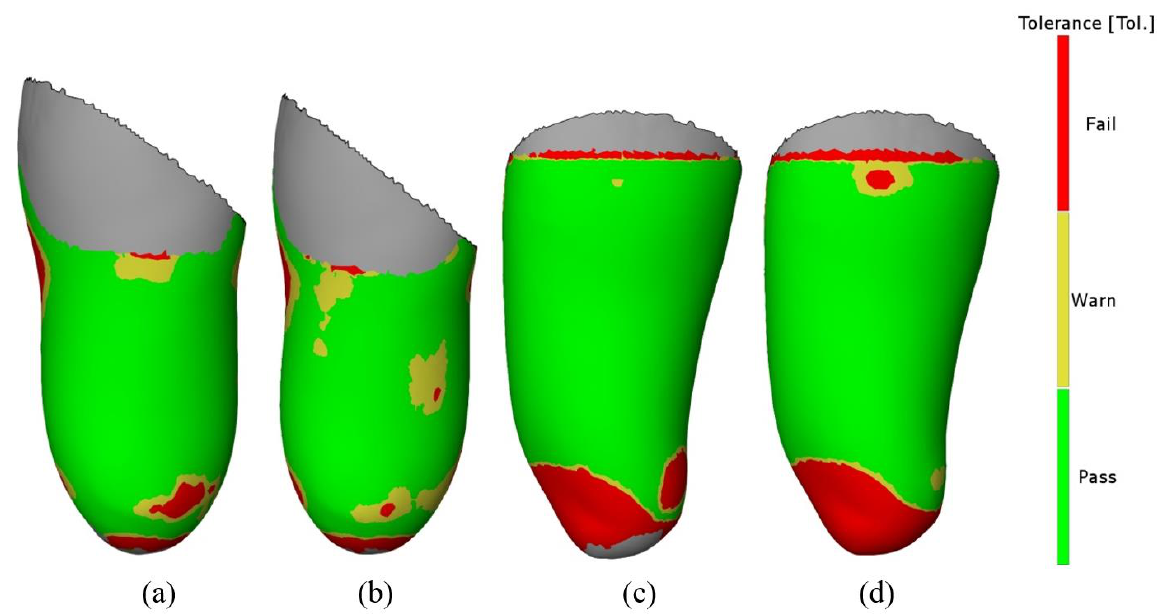
Figure 15. Deviation map regarding the assumed 1 mm tolerance: ( a ) VAC PLA, ( b ) VAC TPE, ( c ) VEL PLA, and ( d ) VEL TPE.